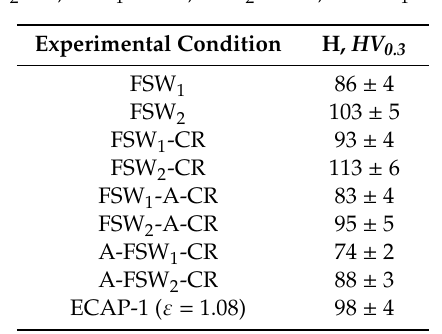
Table 3. Microhardness mean values in the nugget zone for the di ff erent experimental